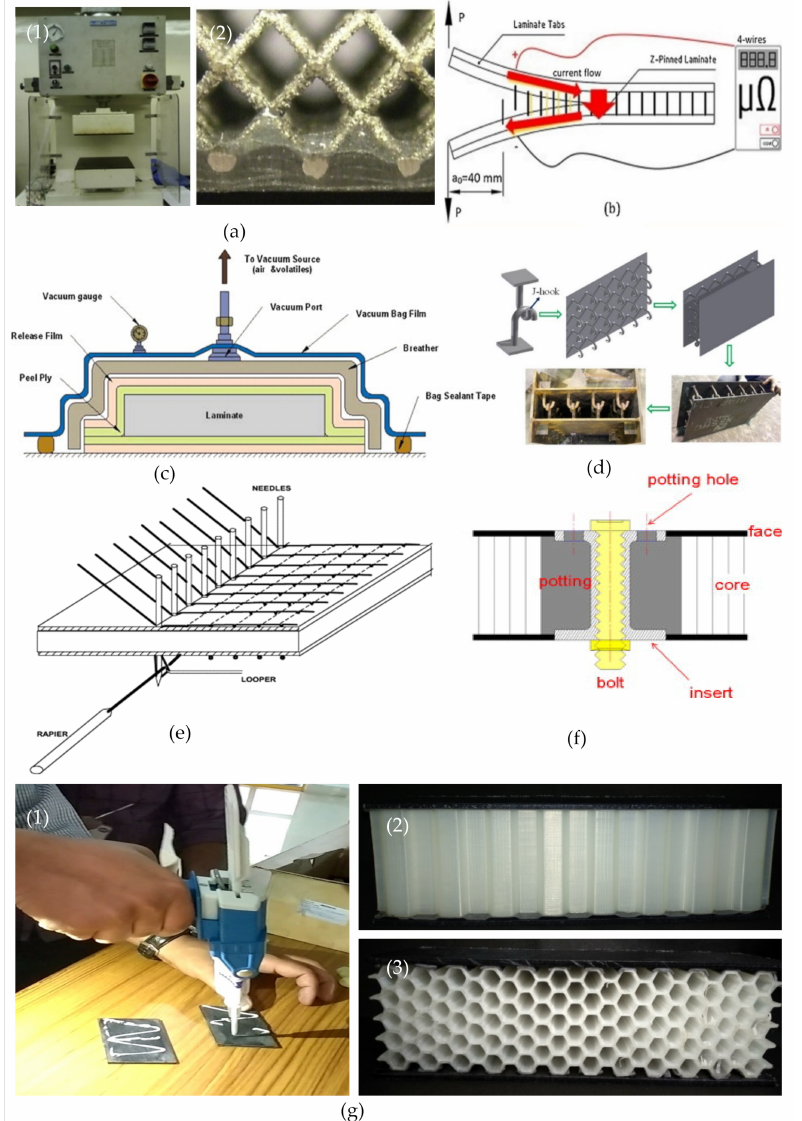
Figure 17. ( a ) Heated press (1) manufacture setup (2) skin–core bond details of SS316L lattice core and CFRP skins [158], ( b ) Z-pinning technique [159], ( c ) Vacuum beg setup [160], ( d ) J-hooking technique [161], ( e ) Stitching technique [162], ( f ) Bolting technique [163], ( g ) Adhesive